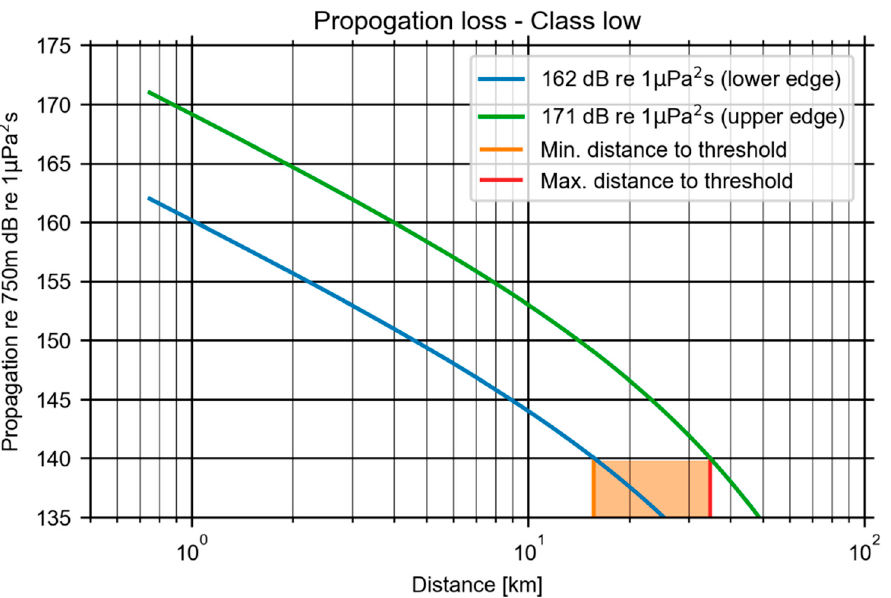
Figure 2. Influence on the propagation range of noise levels to fall below certain thresholds (SEL 140 dB re 1 µ Pa 2 s), based on the source intensity difference implied due to the value code classification. The transmission loss was calculated with formula (1).